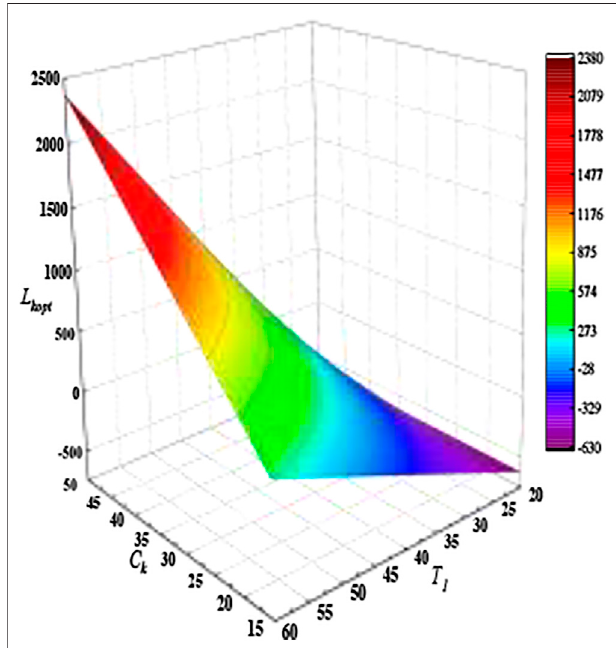
FIGURE 4 | Real estate business ’ s optimal pro fi t and carbon allowance, external carbon